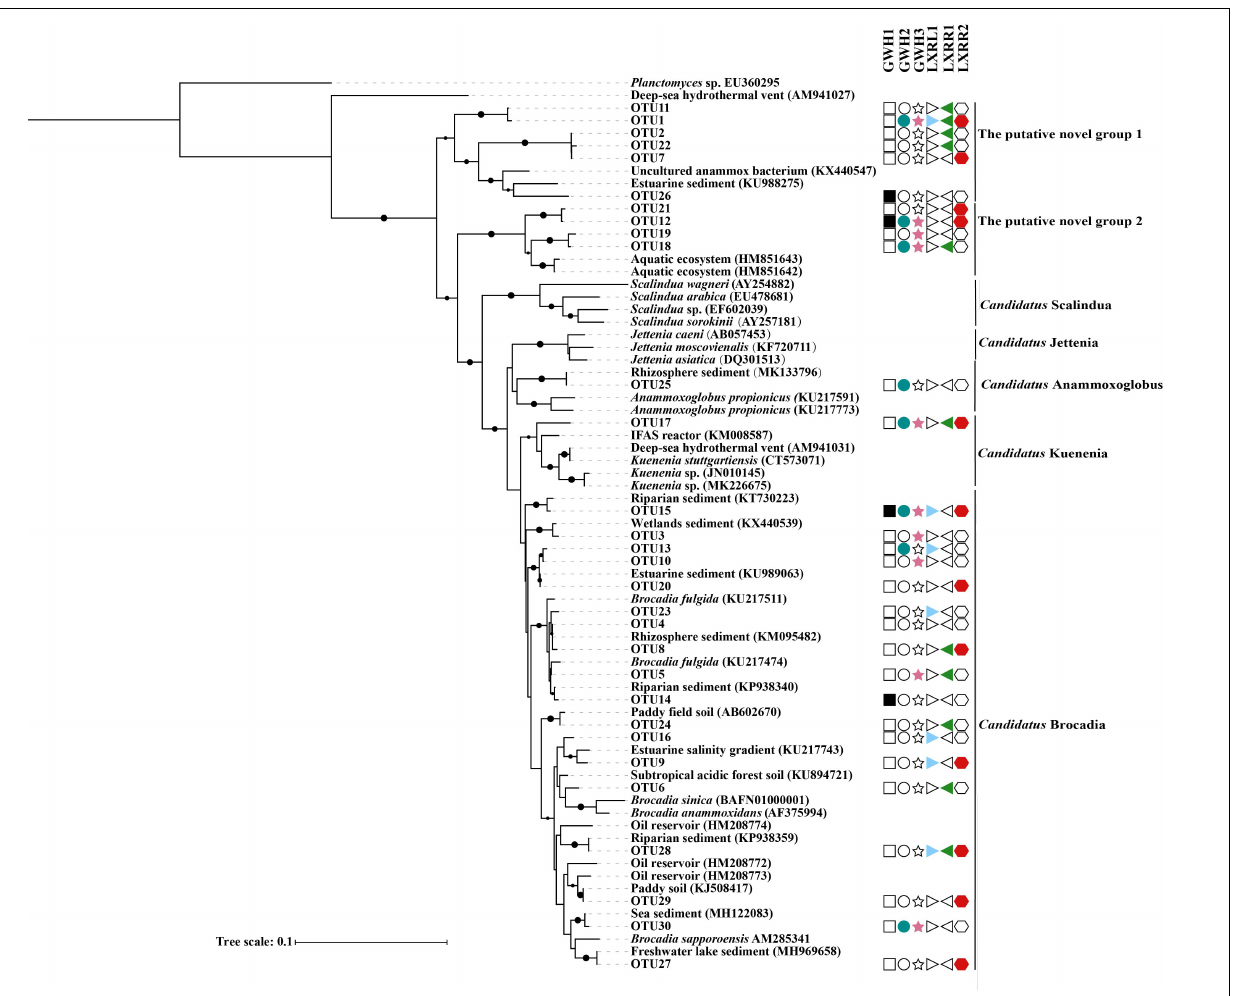
FIGURE 3 | The Neighbor-Joining tree showing the relationship among the top 30 dominant OTU sequences and the reference sequences from the NCBI database. Different shapes with different colors were used to code 6 samples, and empty symbols represent no sequence in the corresponding sample. Bootstrap values were 1,000 replicates. The scale bar represented 10% of sequence